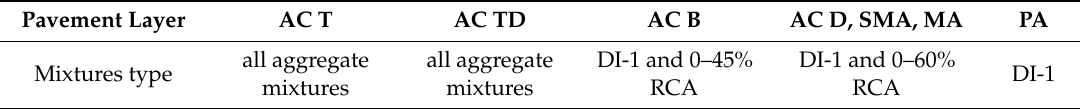
Table 6. The possibility of using RCA in flexible pavements according to technical requirements in